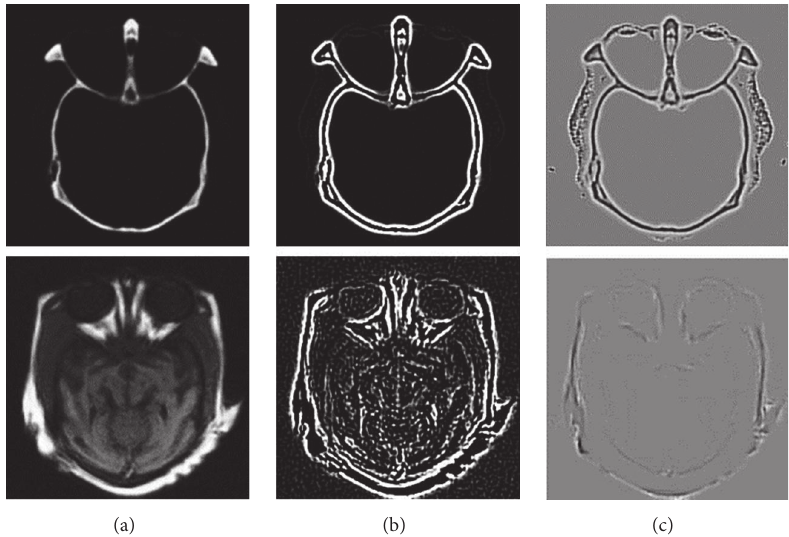
Figure 2: (a) The source images, (b) the structure information of LOG, and (c) the local structure information normalization.